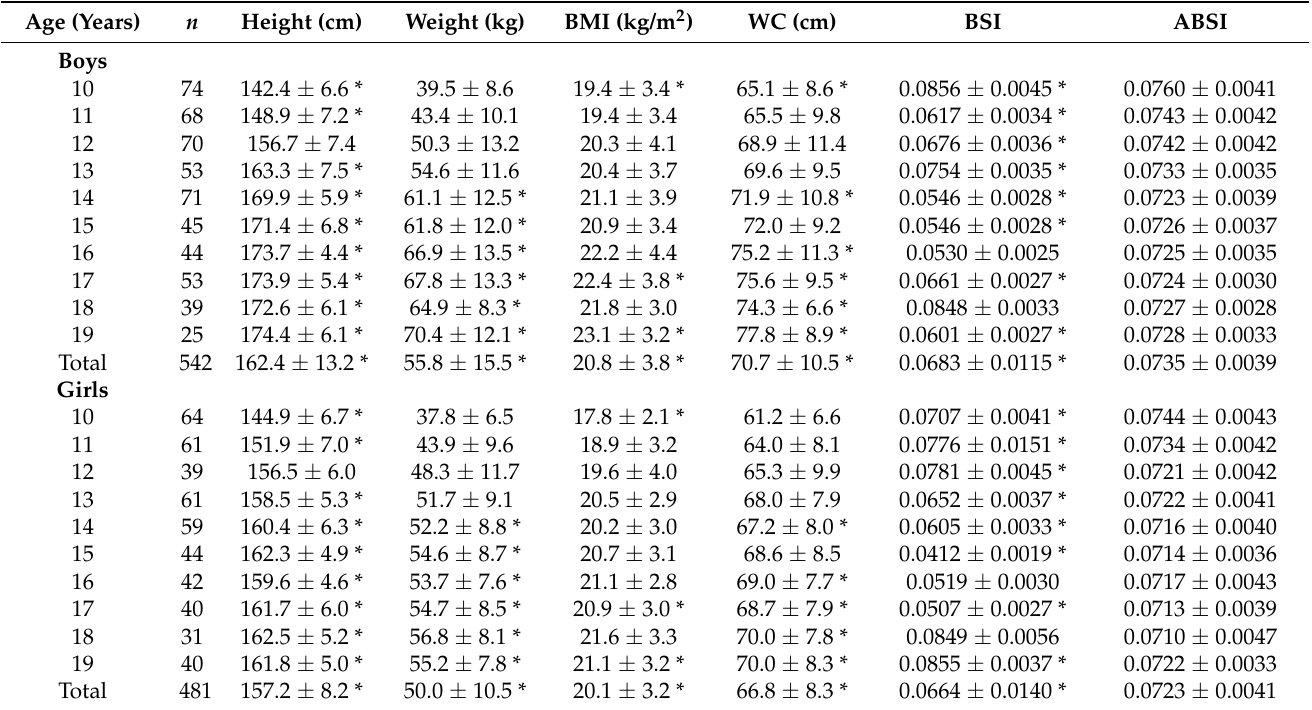
Table 1. Characteristics of the participants according to